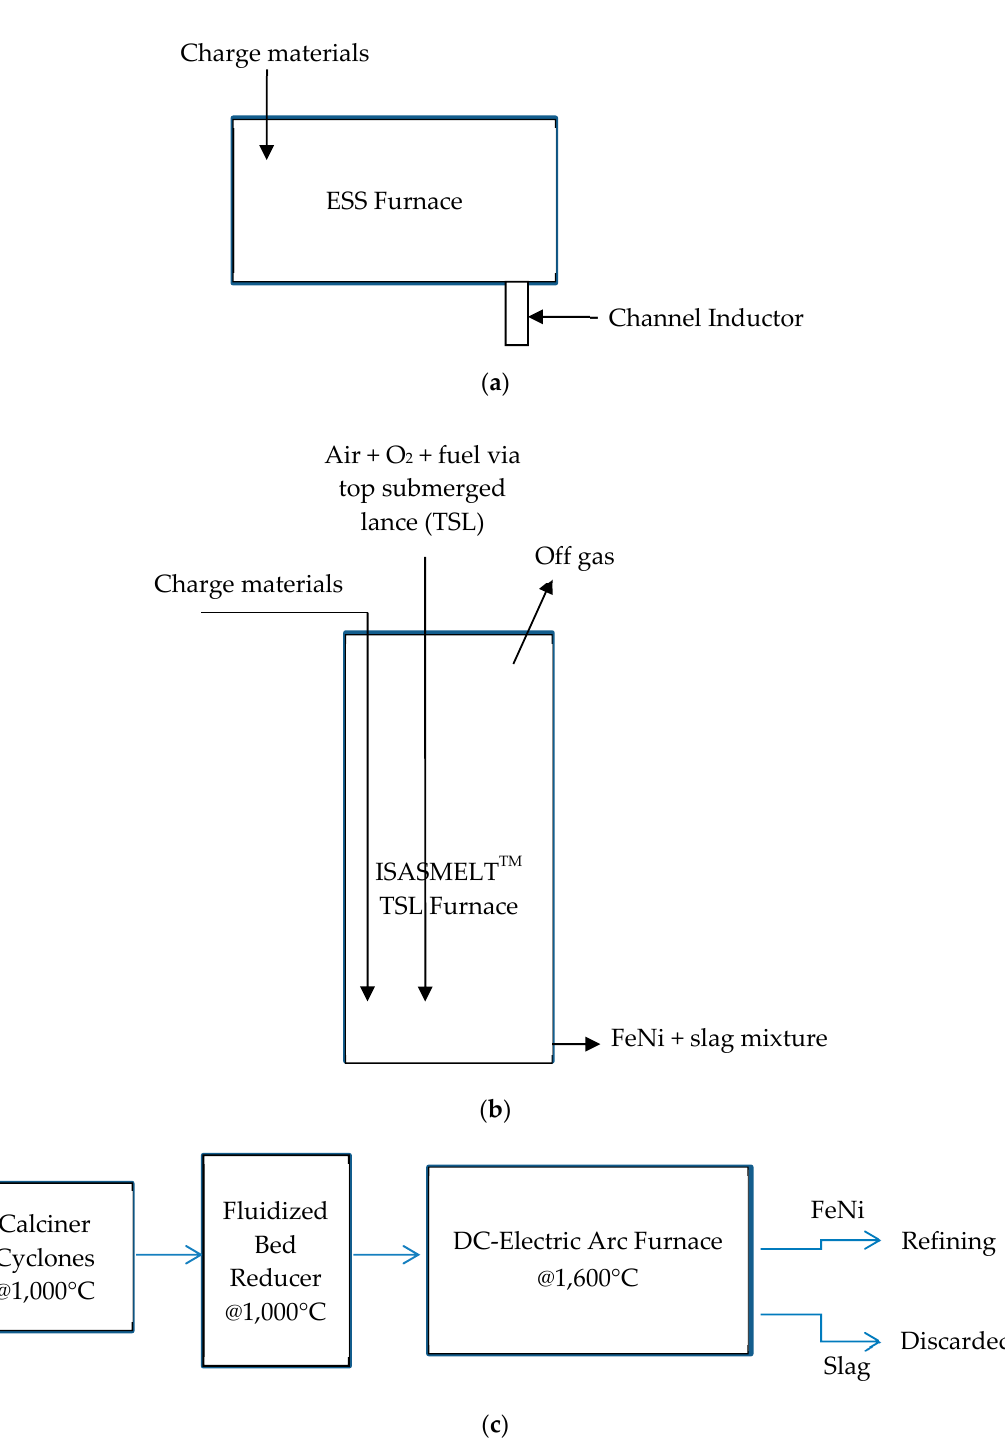
Figure 3. ( a ) Schematic drawing of envirosteel smelter (ESS) smelting technology. ( b ) Schematic of the ISASMELT TM top submerged lance (TSL) technology. ( c ) Main steps in nickel smelting technology (NST).